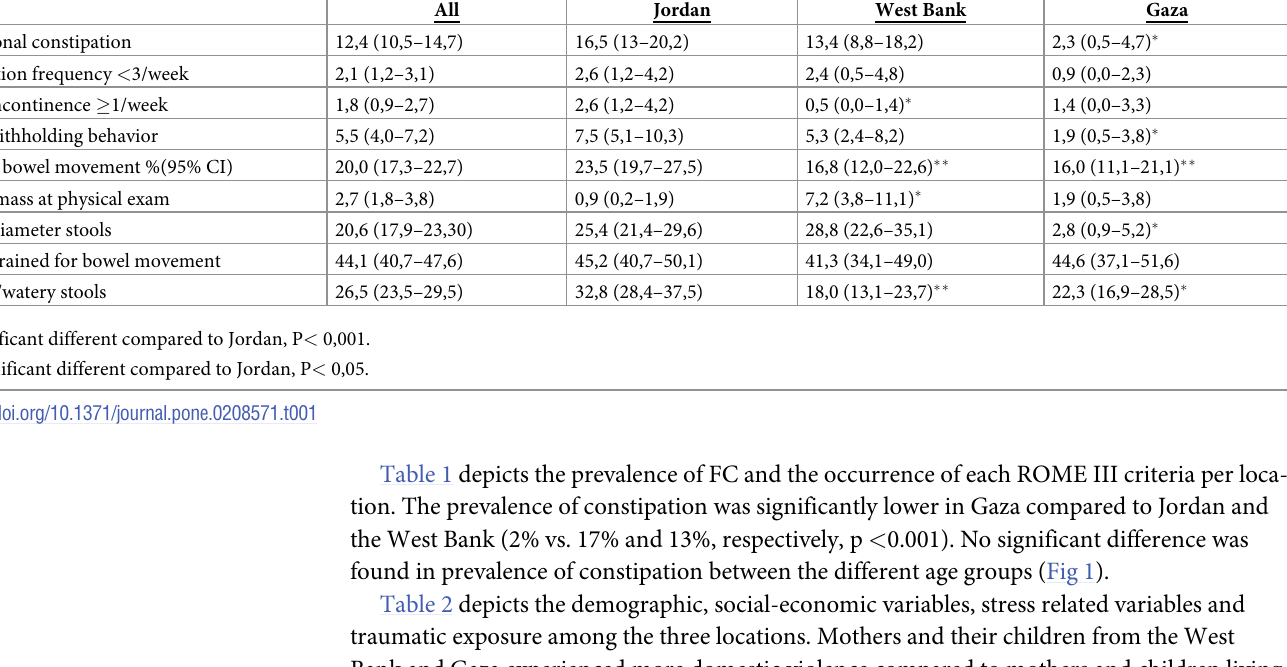
Table 1. Prevalence of functional constipation, and defecation pattern in total sample and per location in percentage (95% confidence interval). All